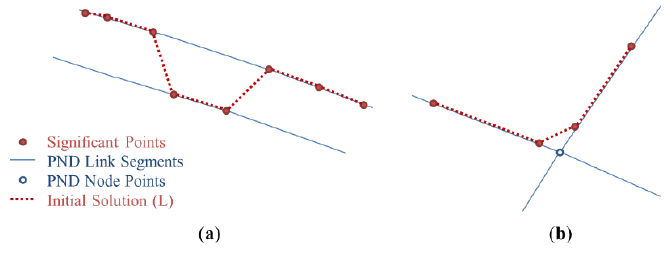
Figure 4. Error cases in initial solution (thin lines refer to existing PND, and thick and dotted lines refer to the initial solution of the significant points): ( a ) Example of errors on dual-lined segments; ( b ) Examples of errors near the